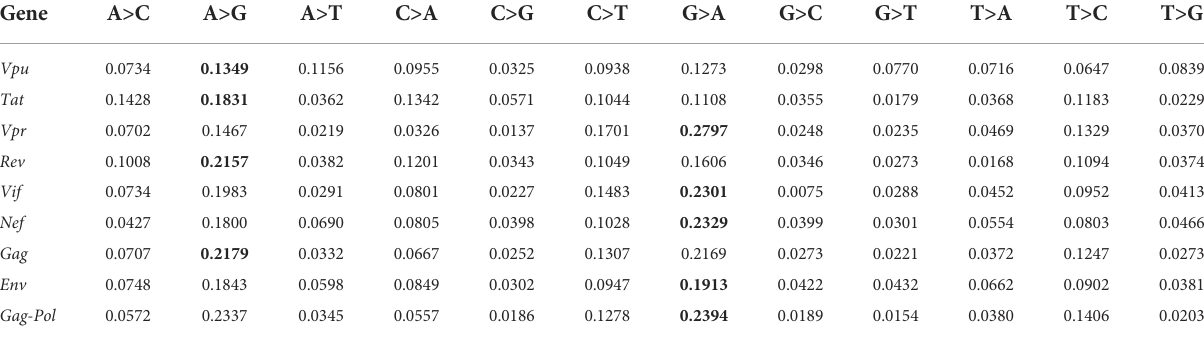
TABLE 1B The ratios of 12 non-unique mutations per